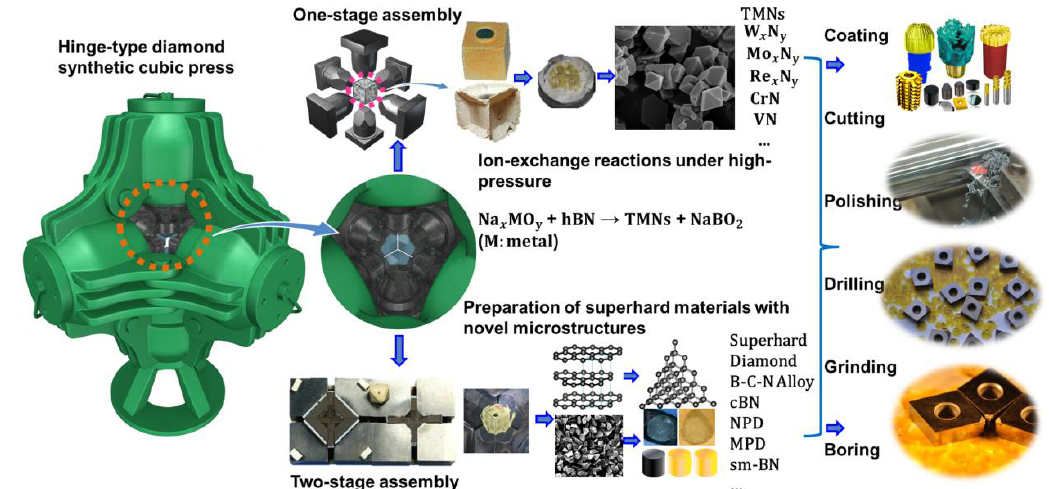
Figure 2. Schematic illustrations of the preparation of novel transition metal nitride alloys and superhard light-element nitride materials with two different sets of experimental assemblies involving one-stage assembly with pressure transmitting medium of pyrophyllite and two-stage assembly with pressure transmitting medium of MgO on basis of a hinge-type cubic press.